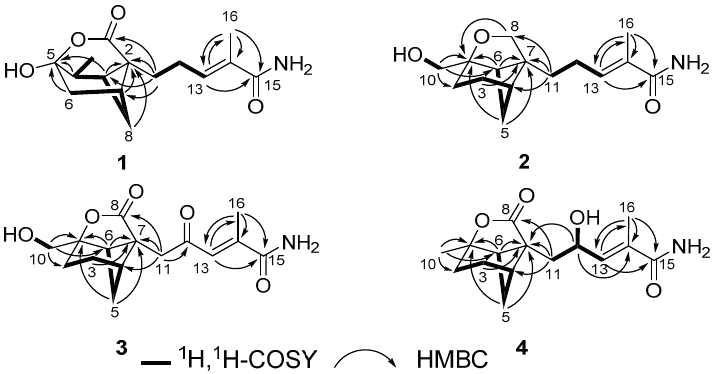
Figure 2. The 1 H- 1 H-COSY and selected HMBC (H → C) correlations for 1 – 4